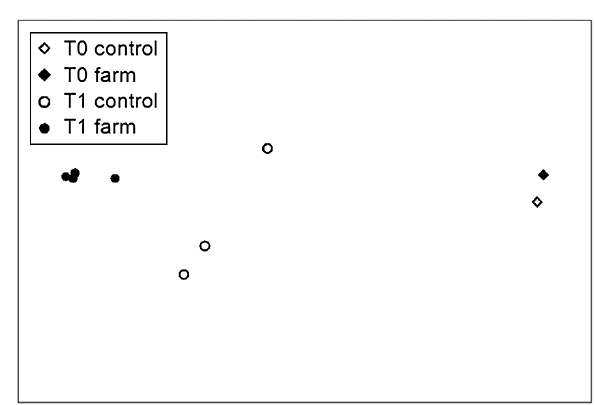
Fig. 5. Non-metric multi-dimensional scaling (nMDS; resem- blance: S17 Bray-Curtis similarity, 2D stress: <0.01) of the rela- tive fatty acid composition of the harpacticoid copepod family Canuellidae in ‘farm’ and ‘control’ sites at Stn SS (see Table 1 legend for abbreviation) at a scallop farm in Laizhou Bay, China before (T0) and during (T1) seasonal aquaculture in